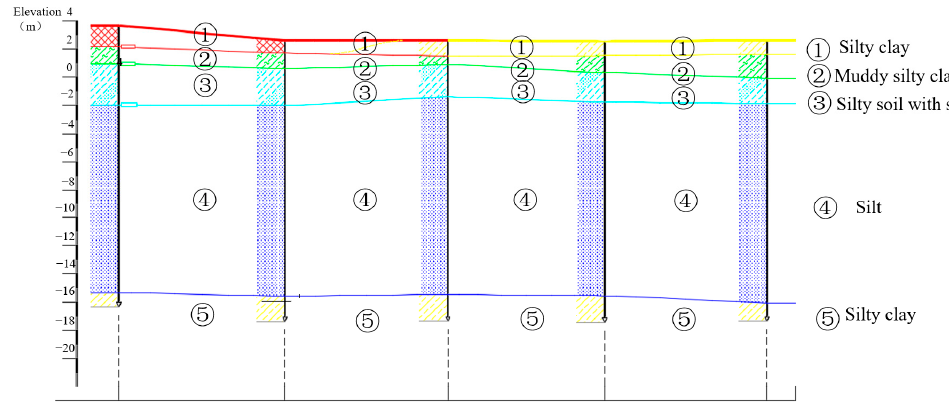
Figure 1. Geology of the place of study.